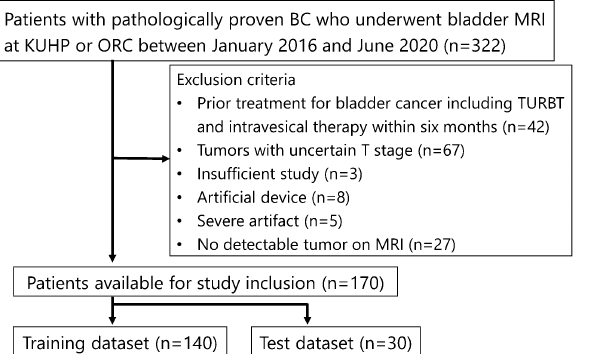
Figure 1. Flow chart of patient selection. KUHP Kyoto University Hospital, ORC Osaka Red Cross Hospital, TURBT transurethral resection of bladder